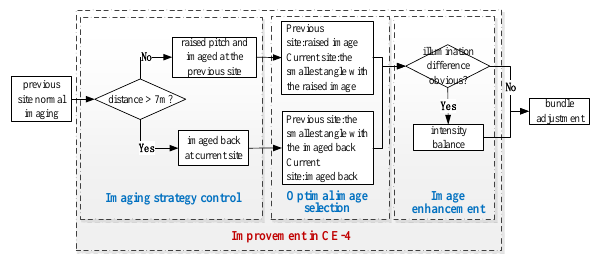
Figure 3. Flowchart of visual localization of CE-4 rover